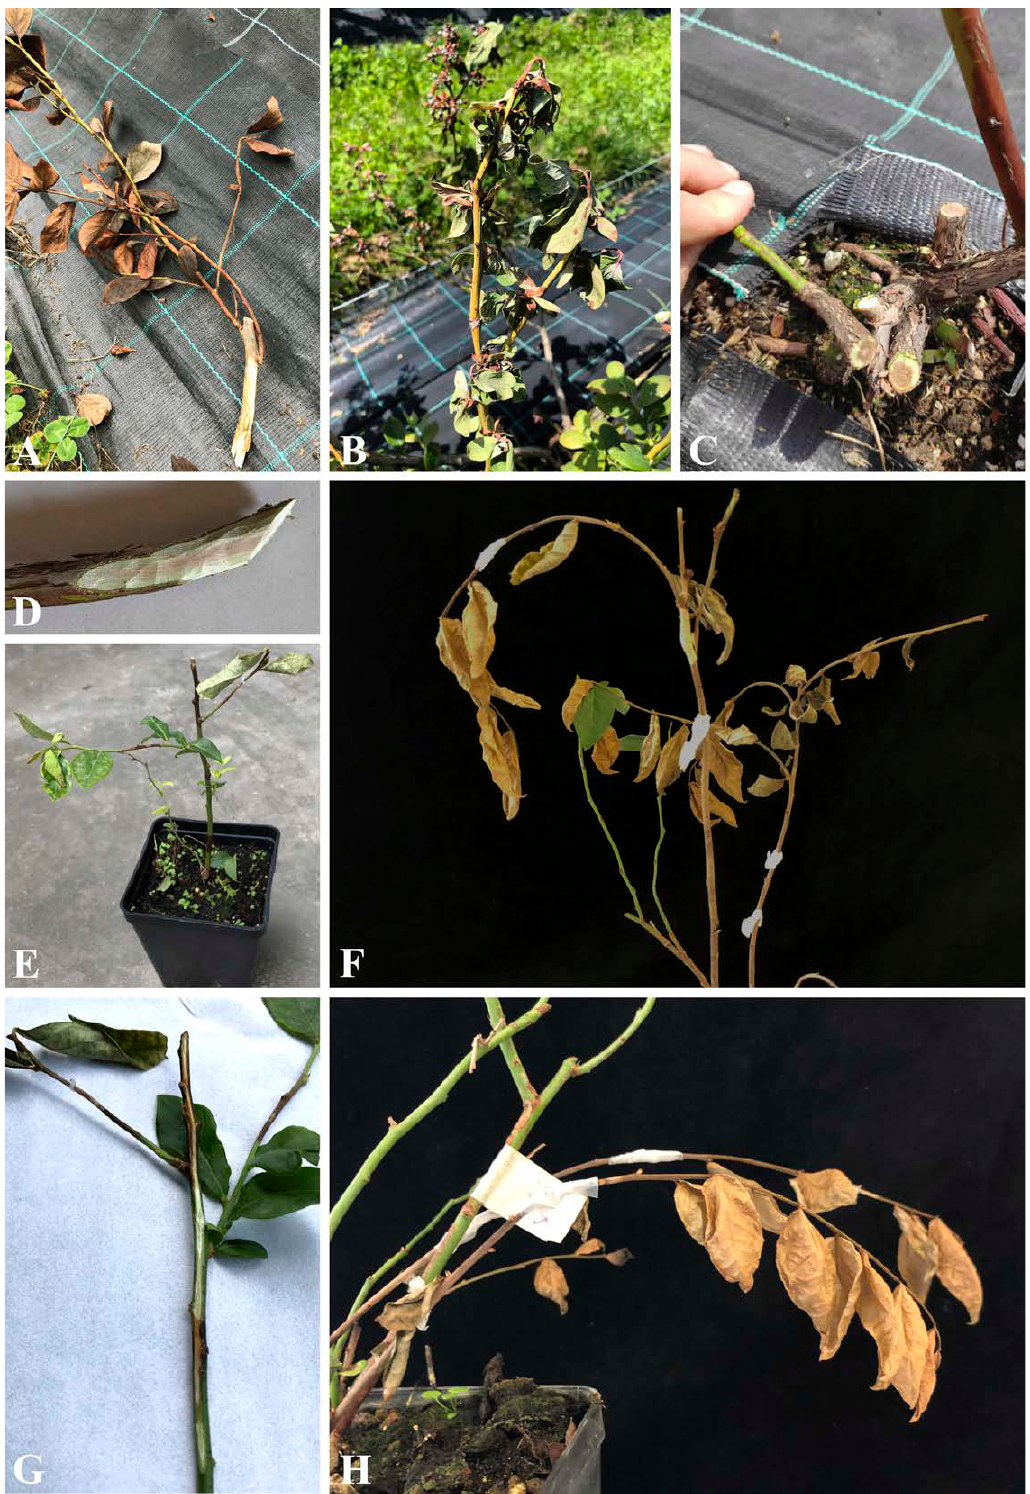
Figure 1. Natural dieback (A) and stem blight (B) of Vaccinium corymbosum ‘Blue Ribbon’ in the field, and a stem showing internal necrosis in the wood of a cultivated plant of ‘Top Shelf’ (C, D). Wilting and internal discolouration caused by inoculation of Diaporthe rudis (E, G), and death of leaves and stems caused by Neofusicoccum parvum inoculation (F,